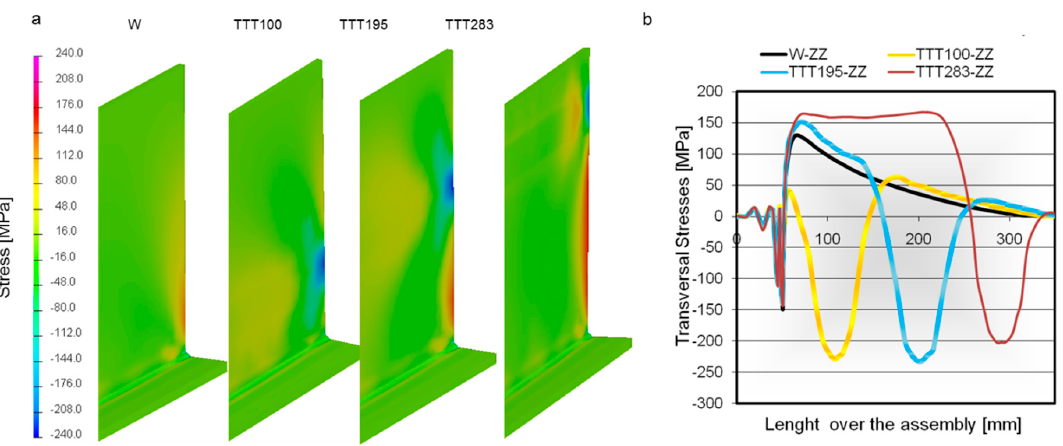
Figure 9. ( a ) Residual stresses for several htTTT tests; ( b ) stress comparison along the measurement line (Figure 3a).